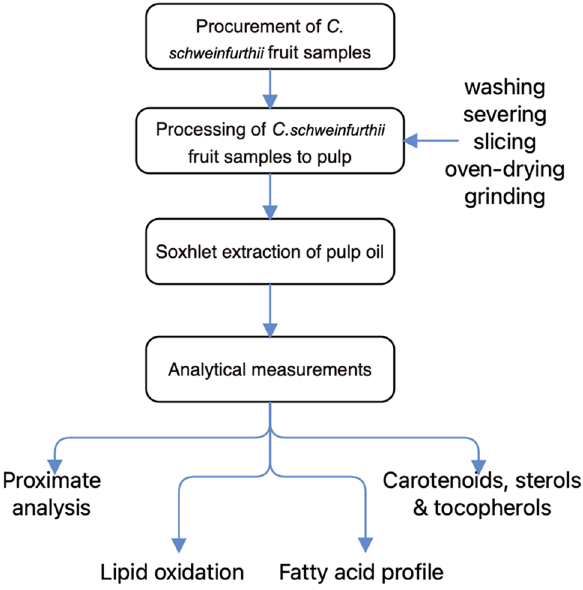
Figure 1. A schematic overview of the experimental program of this current study, showing the major stages, from procurement of C. schweinfurthii fruit samples, processing into the pulp, followed by the Soxhlet extraction of its oil, and subsequent analytical